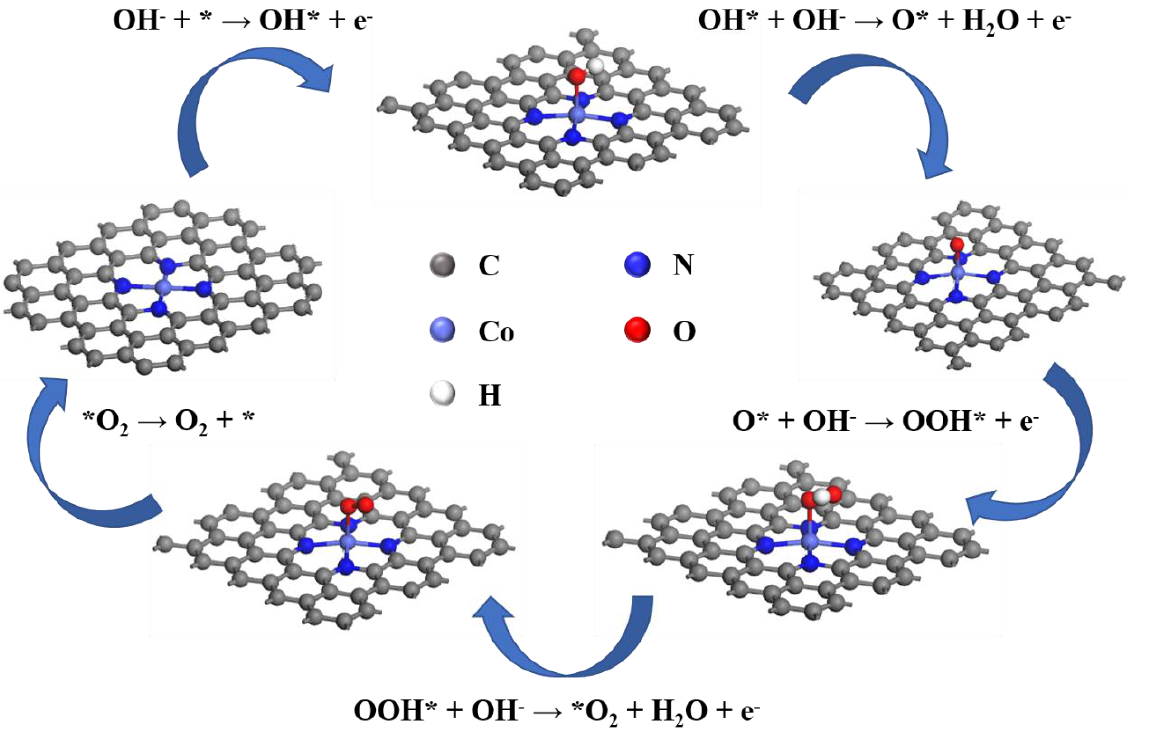
Figure 5. Structural diagrams of Co-N-C for each primitive process of OER (alkaline